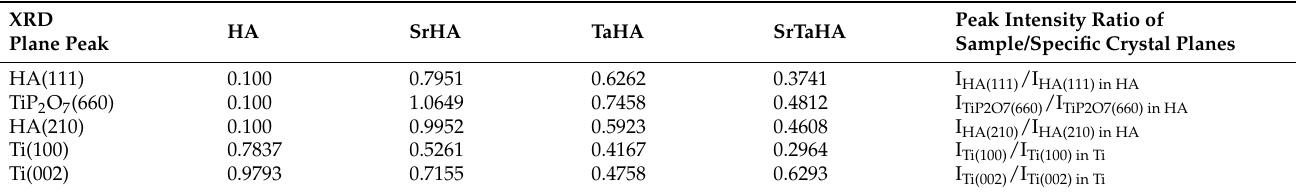
Table 3. Peak intensity ratio of different phases found in XRD.